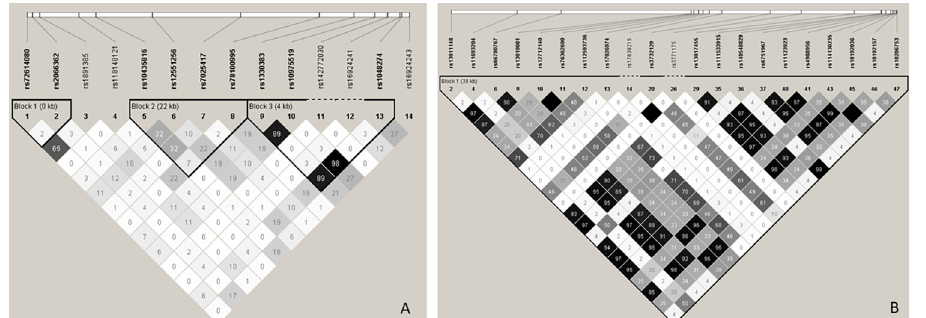
Fig 3. Linkage disequilibrium analysis presenting studied SNVs of IL-33 (A) and ST2 (B) in high or complete linkage disequilibrium.